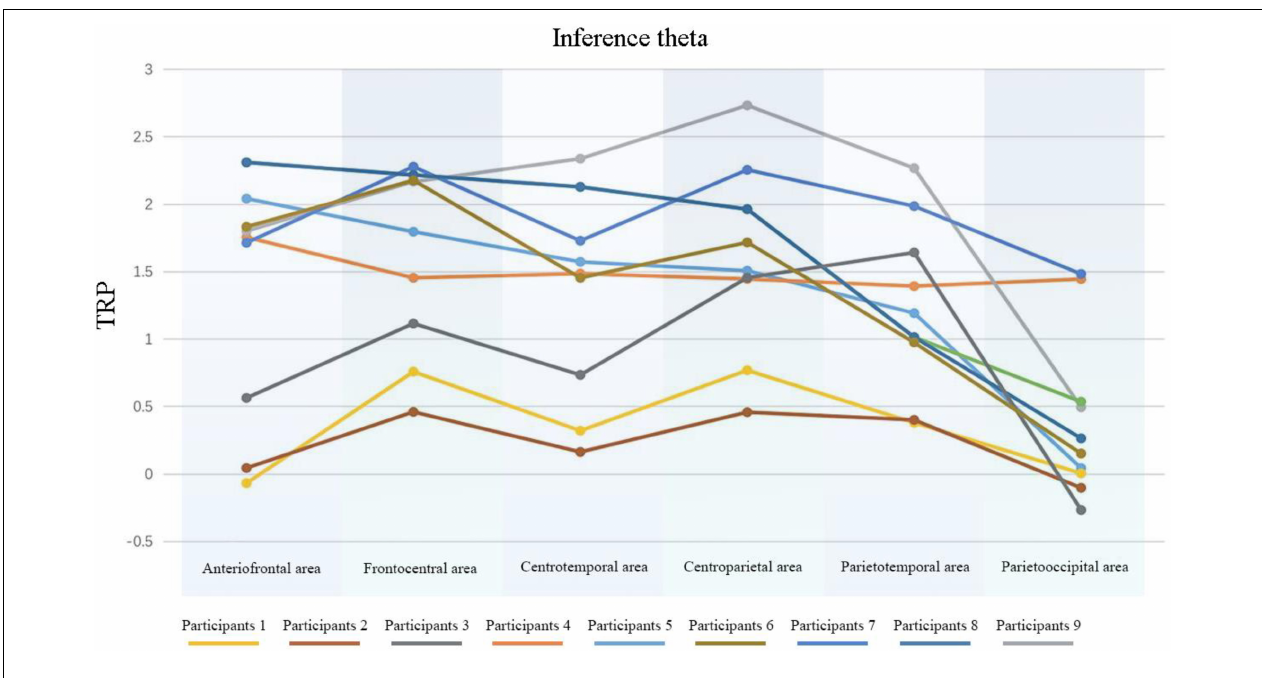
FIGURE 6 | Analogy and inference: theta-band TRP. Each line represents the data of 9 different participants in different